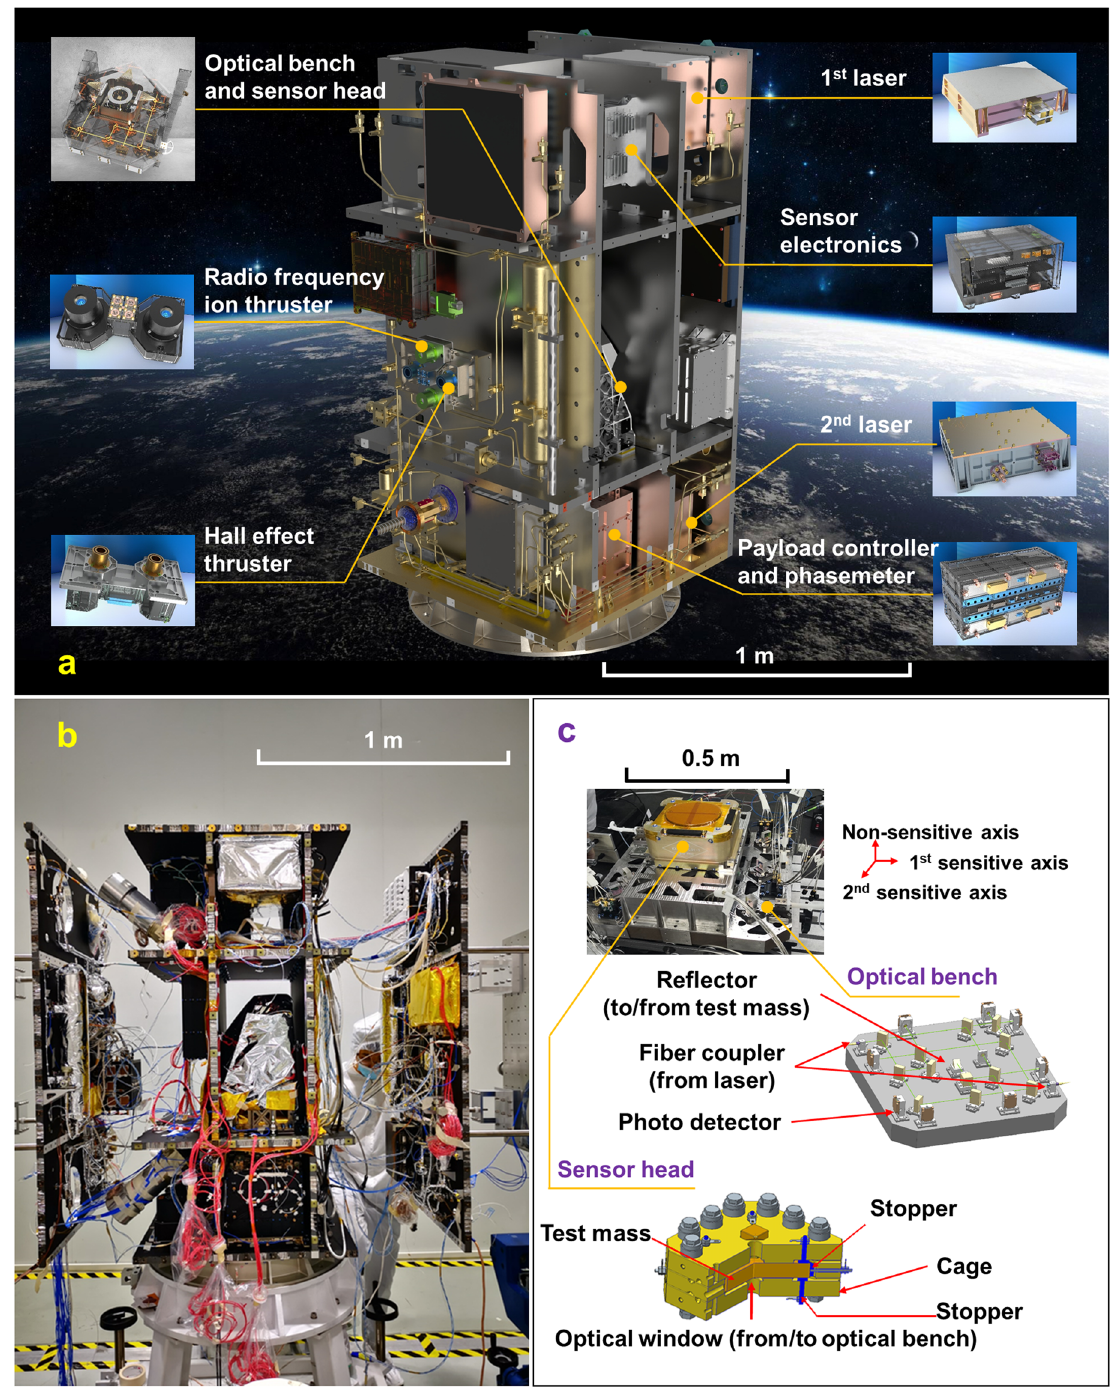
Fig. 1 Anatomy of Taiji-1 and its payloads. a The distribution of the payloads in Taiji-1. The optical bench and the sensor head are integrated in order to ensure the laser beam to get accurate access to the test mass. The difference between the nominal geometric center of the test mass and the mass center of the satellite is smaller than 0.15 mm after the balancing is achieved with a 0.1 mm measurement accuracy. b Taiji-1 satellite before assembling. c The core measurement unit. It contains an optical bench and a sensor head. The plate of the optical bench is made of invar steel, and the mirrors are made of fused silica. The cage of the sensor head is made of the low thermal expansion glass ceramics, and is coated with gold. The test mass is also coated with gold and is made of titanium alloy. The stoppers are used to prevent the test mass from contacting the inner surface of the cage during